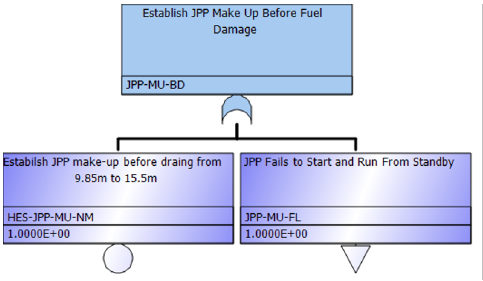
Figure 7. Failure Model of the JPP System.